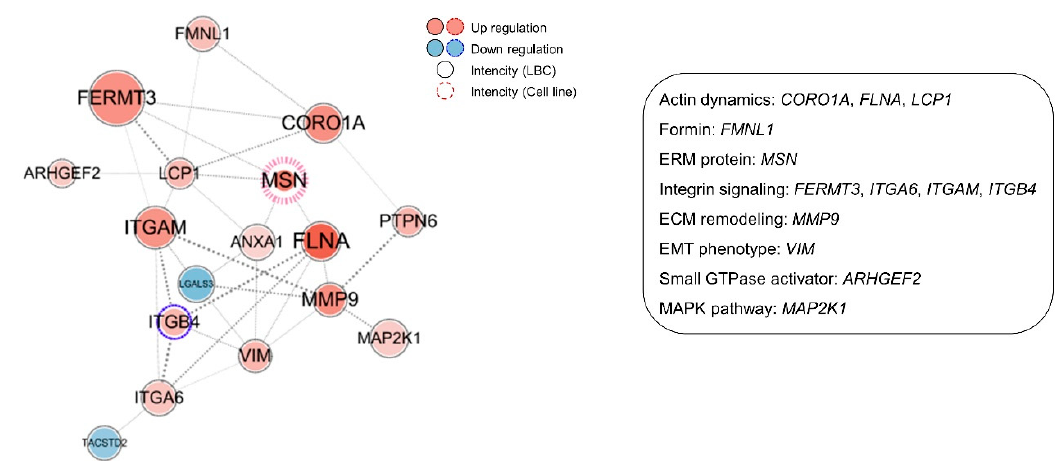
Figure 5. Protein-protein interaction based-network analysis with di ff erentially expressed proteins (DEPs) between muscle-invasive bladder urothelial carcinoma (MIBUC) and non-invasive bladder Figure 5. Protein ‐ protein interaction based ‐ network analysis with differentially expressed proteins urothelial carcinoma (NIBUC) in cell motility. (DEPs) between muscle ‐ invasive bladder urothelial carcinoma (MIBUC) and non ‐ invasive bladder urothelial carcinoma (NIBUC) in cell motility.